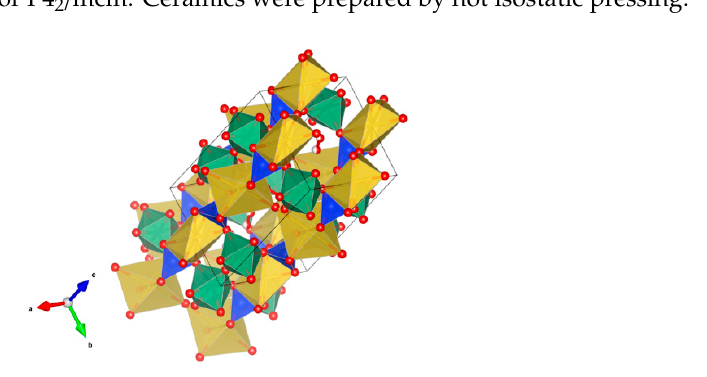
Figure 21. SilicoTitanate (CST). SiTiO 4 . Structure cubic, Sp. gr. Pm3m up to 105 °C, after-